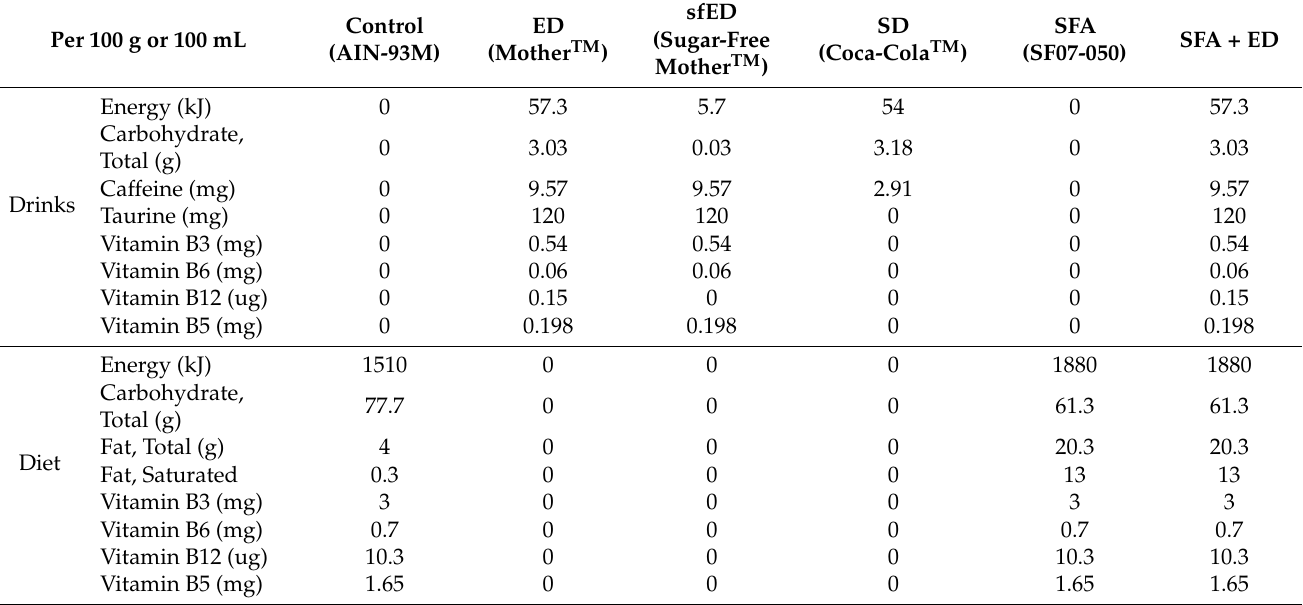
Table 1. Nutrition composition table of energy drinks, soft drink, and